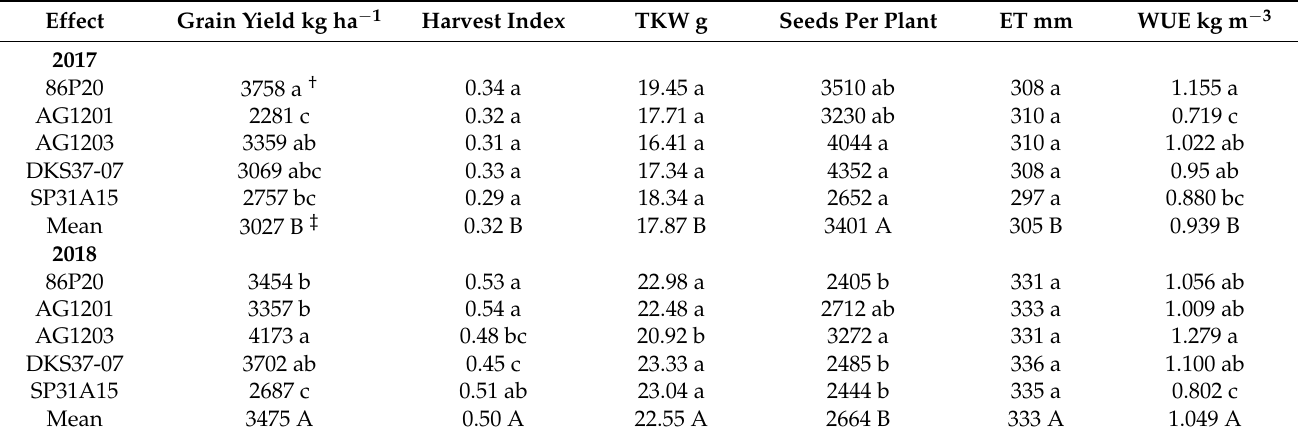
Table 2. Means of grain yield, harvest index, thousand kernel weight (TKW), seeds per plant, evapotranspiration (ET), and water use efficiency (WUE) as affected by year and hybrid interaction.